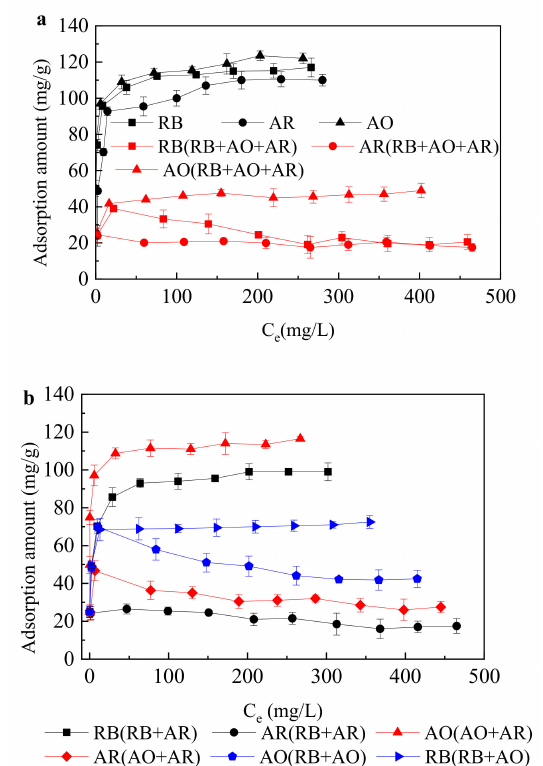
Figure 7. Adsorption isotherm with various dyes. To ensure the adsorbed saturation, the adsorption test was conducted at least 4 h at a certain temperature in a constant temperature oscillating box. ( a ) one component and three component system; ( b ) two component